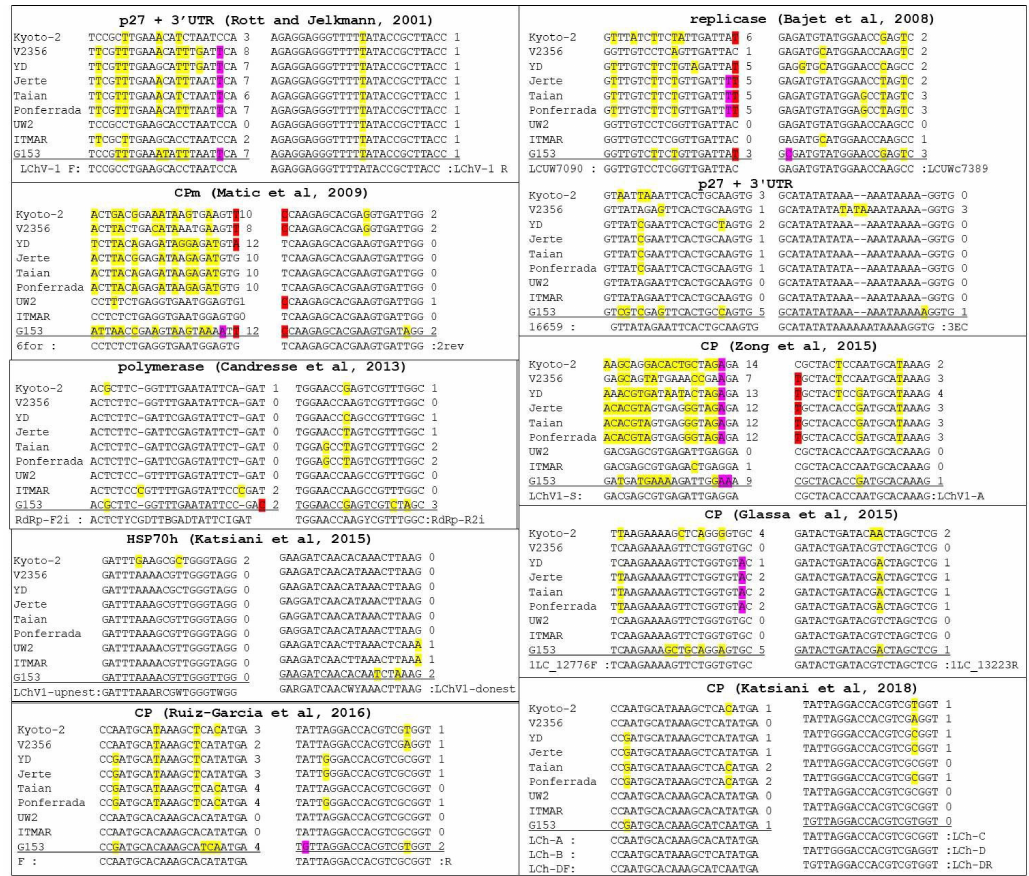
Figure 5. Multiple sequence alignments of the primer binding regions for the detection of LChV1. The position and number of mismatches with the full genome LChV1 isolates representing all phylogenetic groups are indicated. In red, violet and yellow color are presented the mismatches of the primer affecting the first 3′-most nucleotide, the second and third 3′-most nucleotide as well as all other nucleotides, respectively.